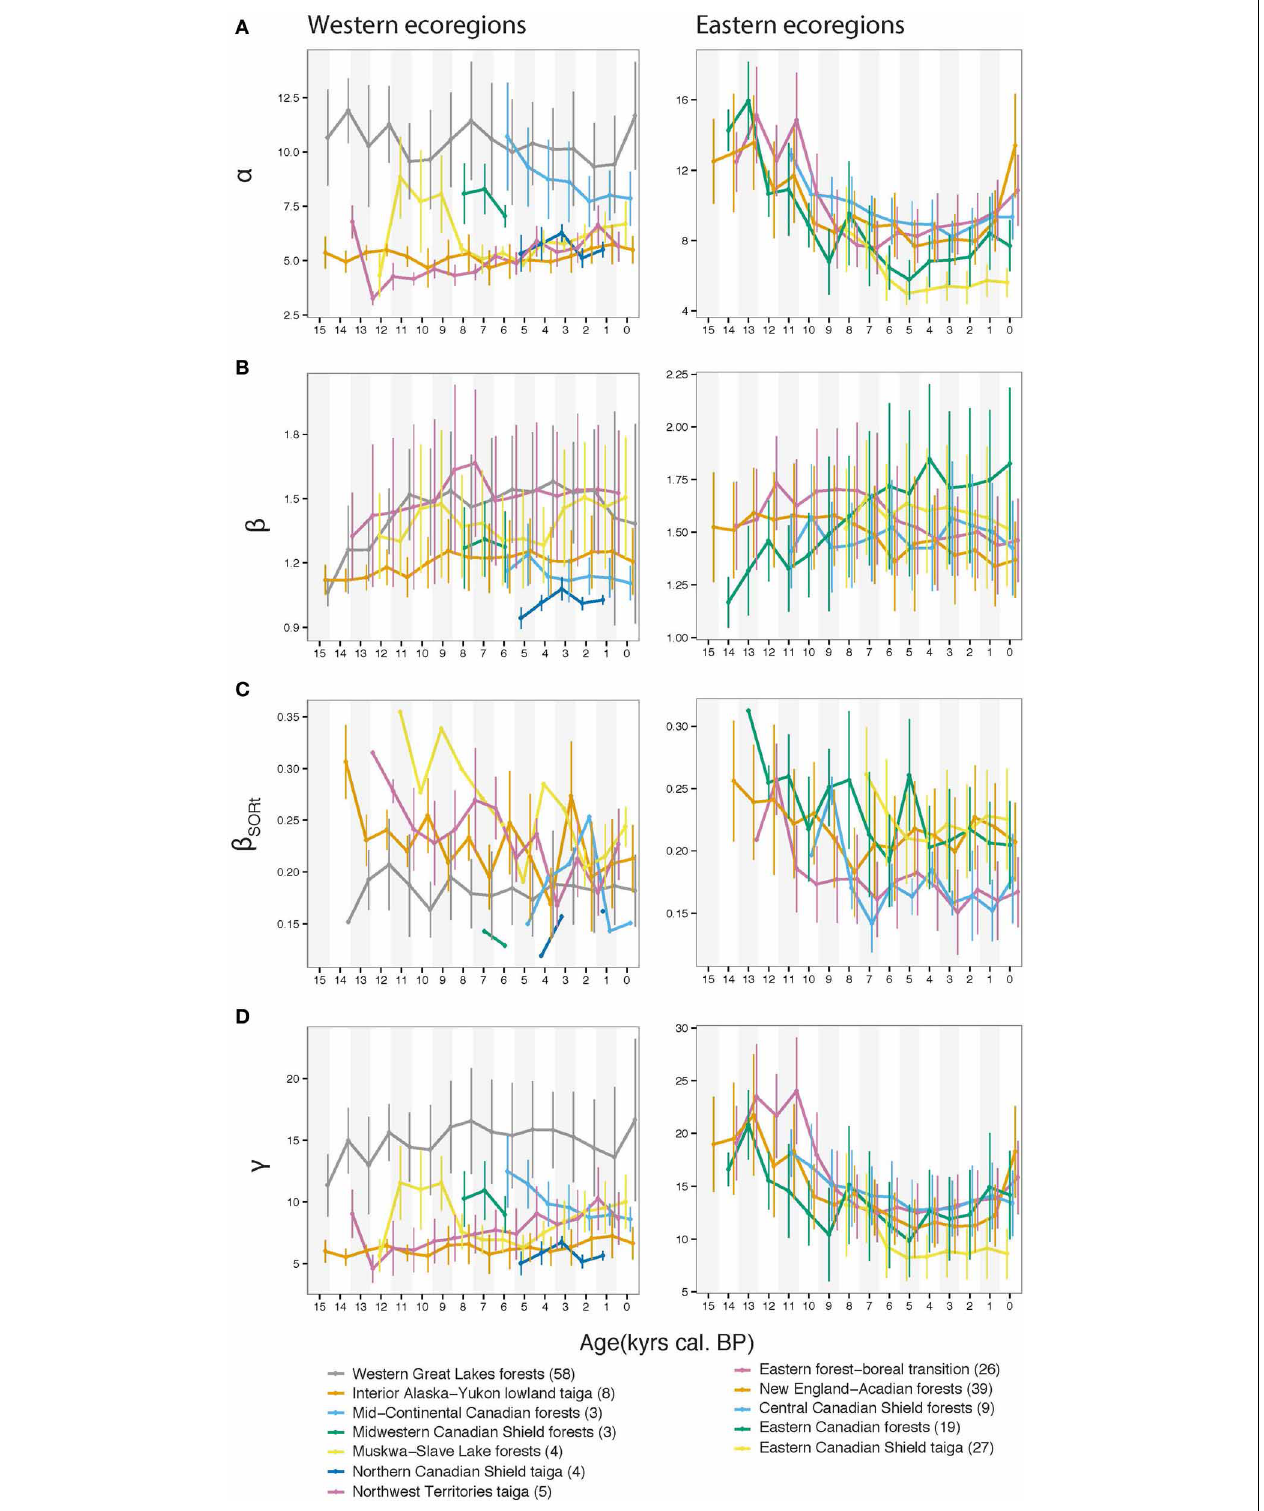
FIGURE 2 | Diversity indices averaged for each ecoregion using 1-ka temporal windows; the site number is indicated in parentheses following ecoregion name labels. (A) α diversity from Shannon entropy number